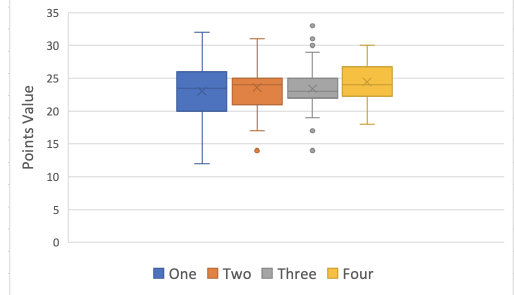
Figure 11. Password security knowledge and password strength. possible points value. Figure 10 shows the box-and- whisker plot. The “X” indicates the average value and the middle bar is the median value. The bars indicate the first and third quartiles while the whiskers indicate the lowest and highest data points excluding